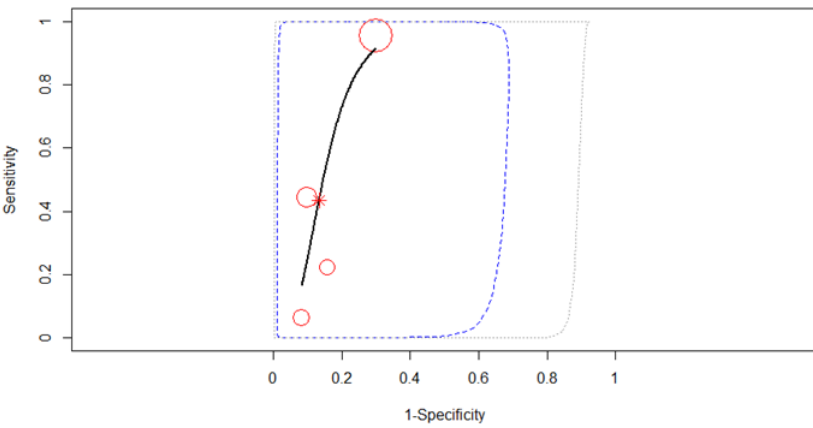
Figure 11. SROC curve with 95% confidence and prediction regions for T1+T2 restaging.